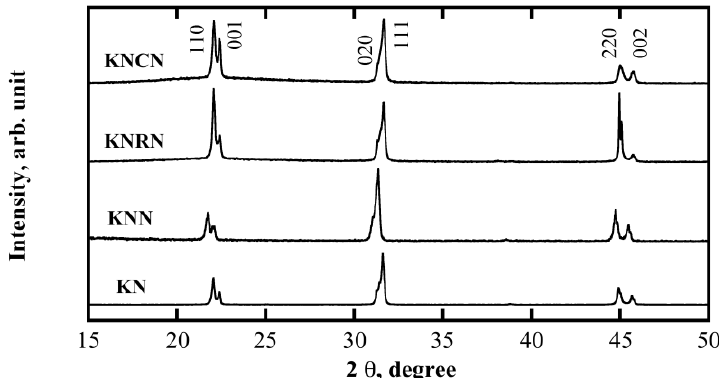
Figure 10. Powder X-ray diffraction patterns of KN: KNbO (K,Na,Rb)NbO , KNCN: (K,Na,Cs)NbO 3 2011 Elsevier and Techna Group